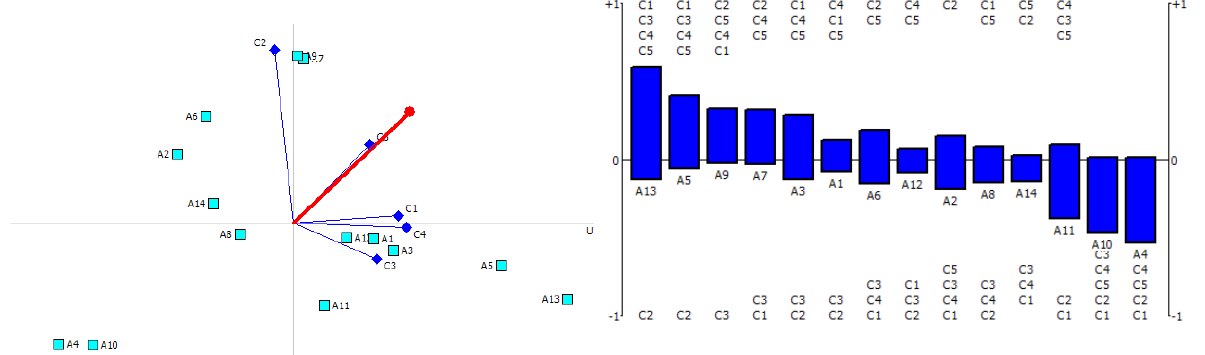
Figure 3. PROMETHEE GAIA